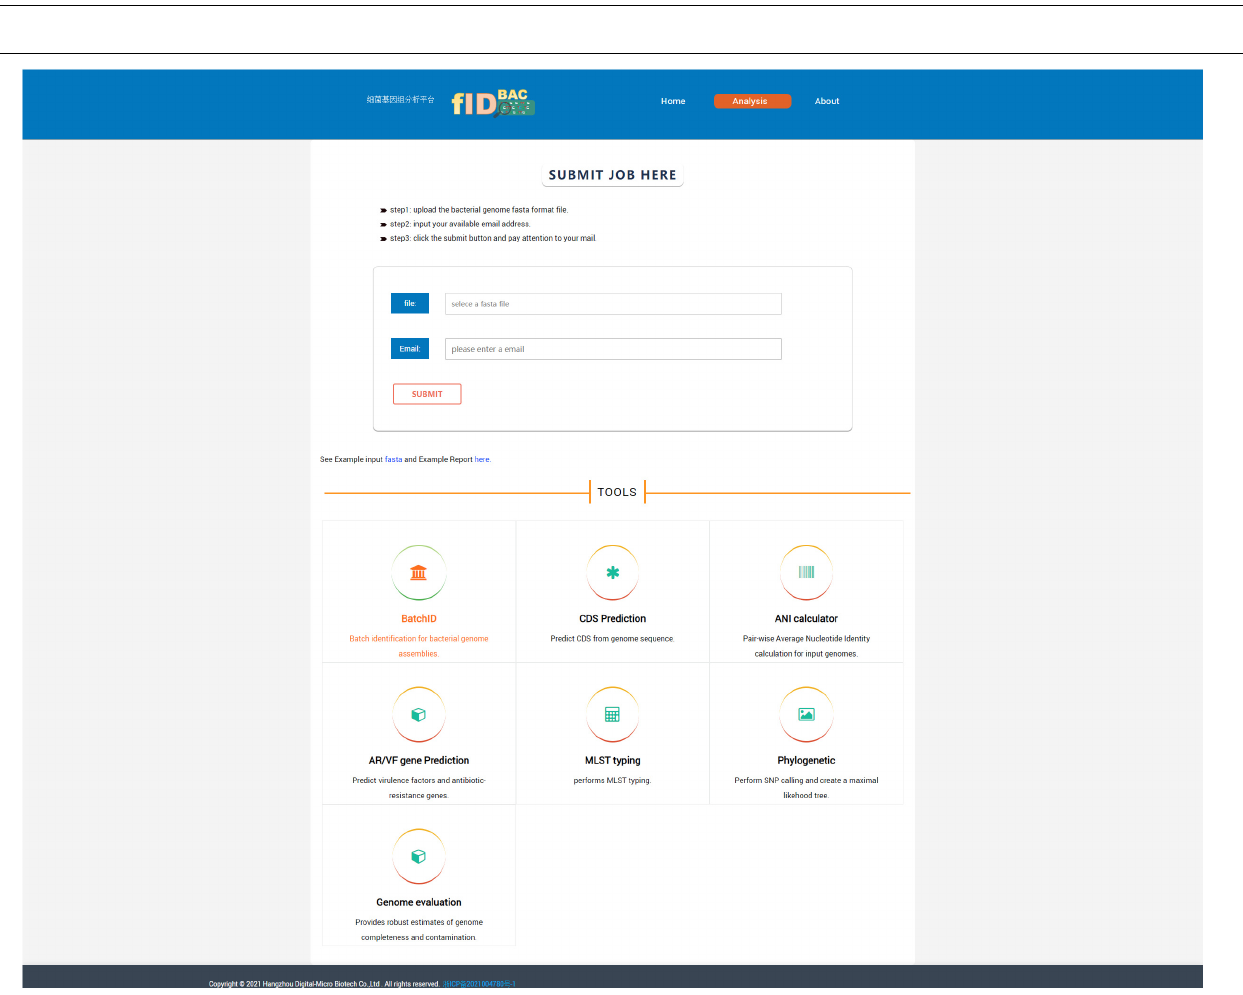
FIGURE 5 | Screenshot of the “Analysis” page. One can submit a full pipeline analysis job here. Alternatively, the link for individual tools leads the user to the corresponding analysis.